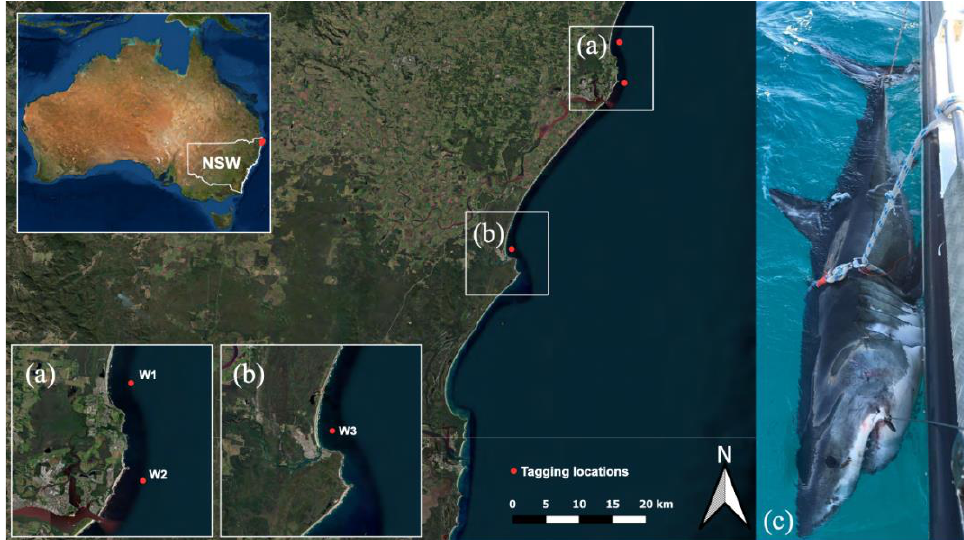
Figure 1. Location of tagging sites (red dots) on the northern New South Wales coast of eastern Australia. ( a ) Lennox Head, tagging site of white shark 1 (W1) and Ballina, tagging site of white shark 2 (W2), ( b ) Evans Heads, tagging site of white shark 3 (W3), and ( c ) W1 secured to the side of the vessel during tagging procedure (image provided by the New South Wales Department of Primary Industries). Map generated in QGIS.